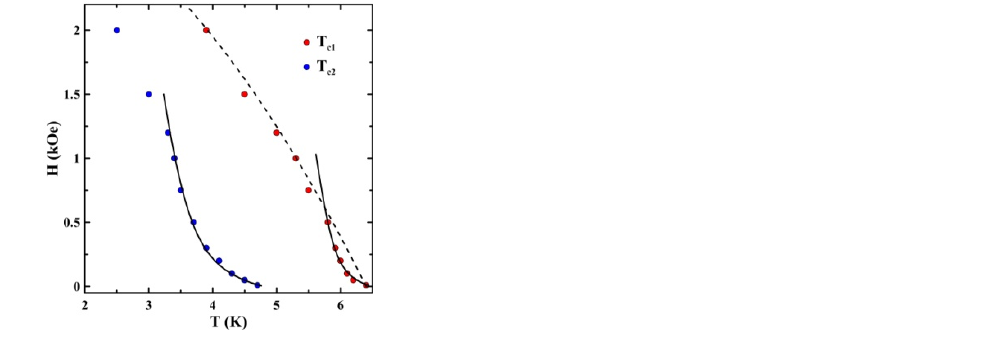
Figure 4. The superconducting-phase diagram obtained from magnetic measurements. The dashed line is a two-fluid model fit. Solid lines show fitting using Equation (13) from [16].